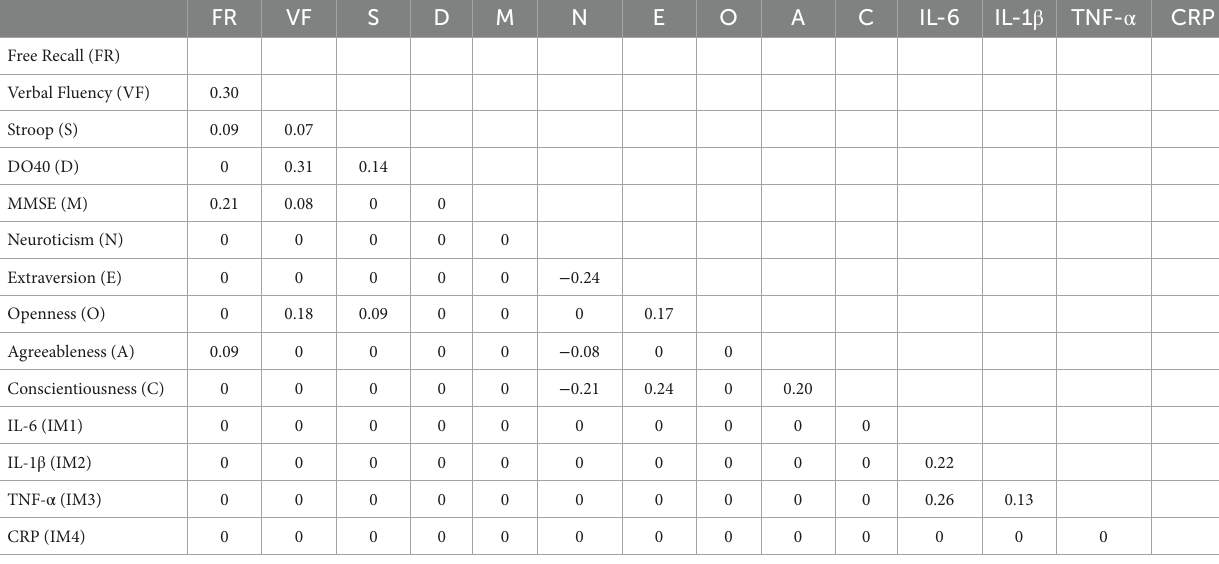
TABLE 3 Partial correlations matrix of network A (cognition, personality, and inflammatory